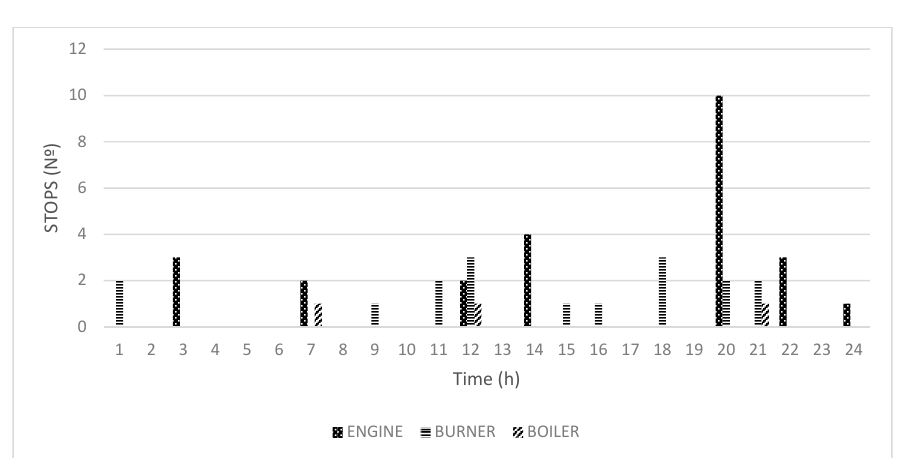
Figure 12. Base engine, burner, and boiler ON/OFF. Energies 2020 , 13 , x FOR PEER REVIEW